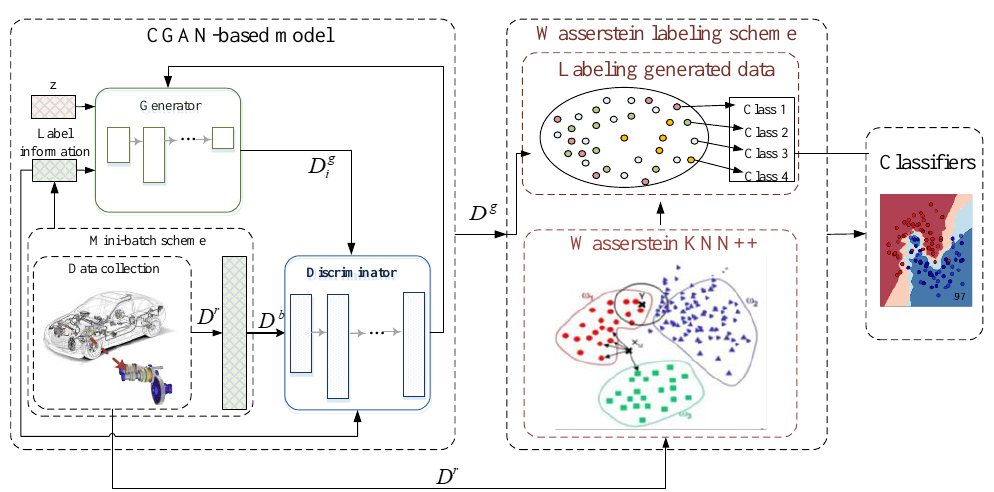
Figure 2. The conceptual working of proposed approach.